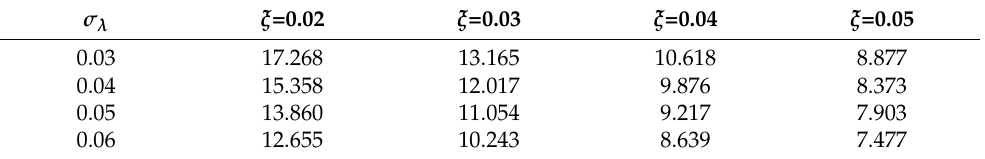
Figure 3. The resonance reduction factor C λ ( ξ ) . Table 5. Several values for the resonance reduction factors C λ ( ξ ) ( nf p / f s = 1). σ